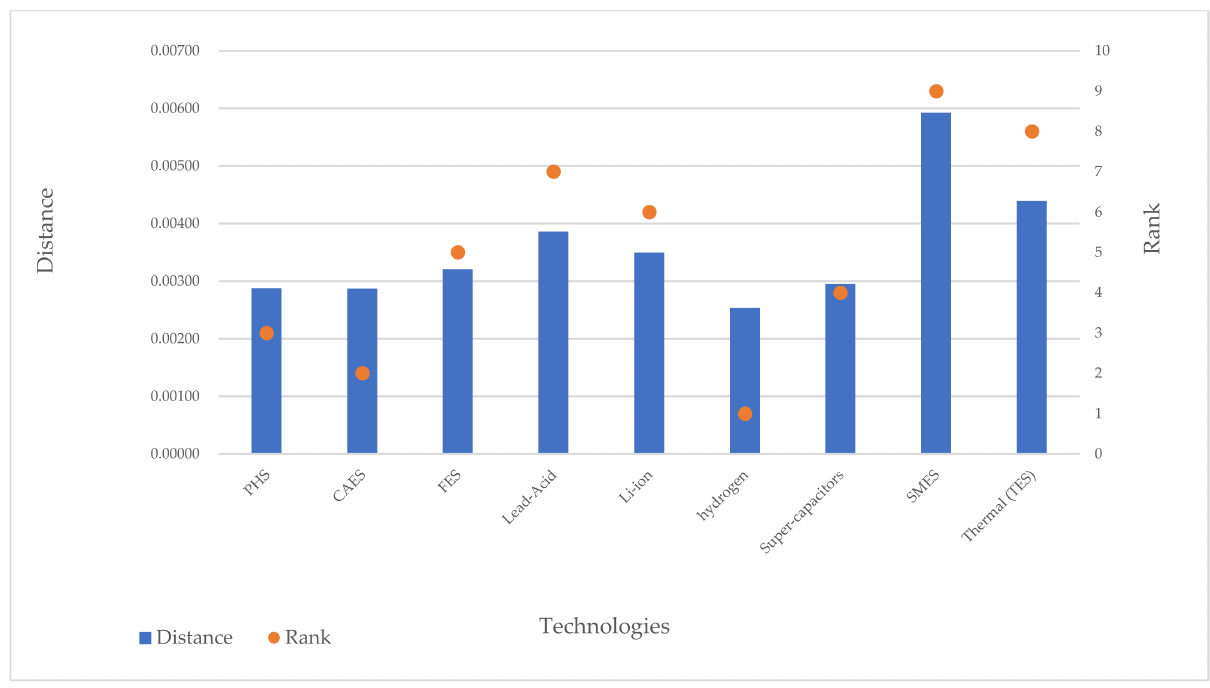
Figure 4. Distance calculation and ranking